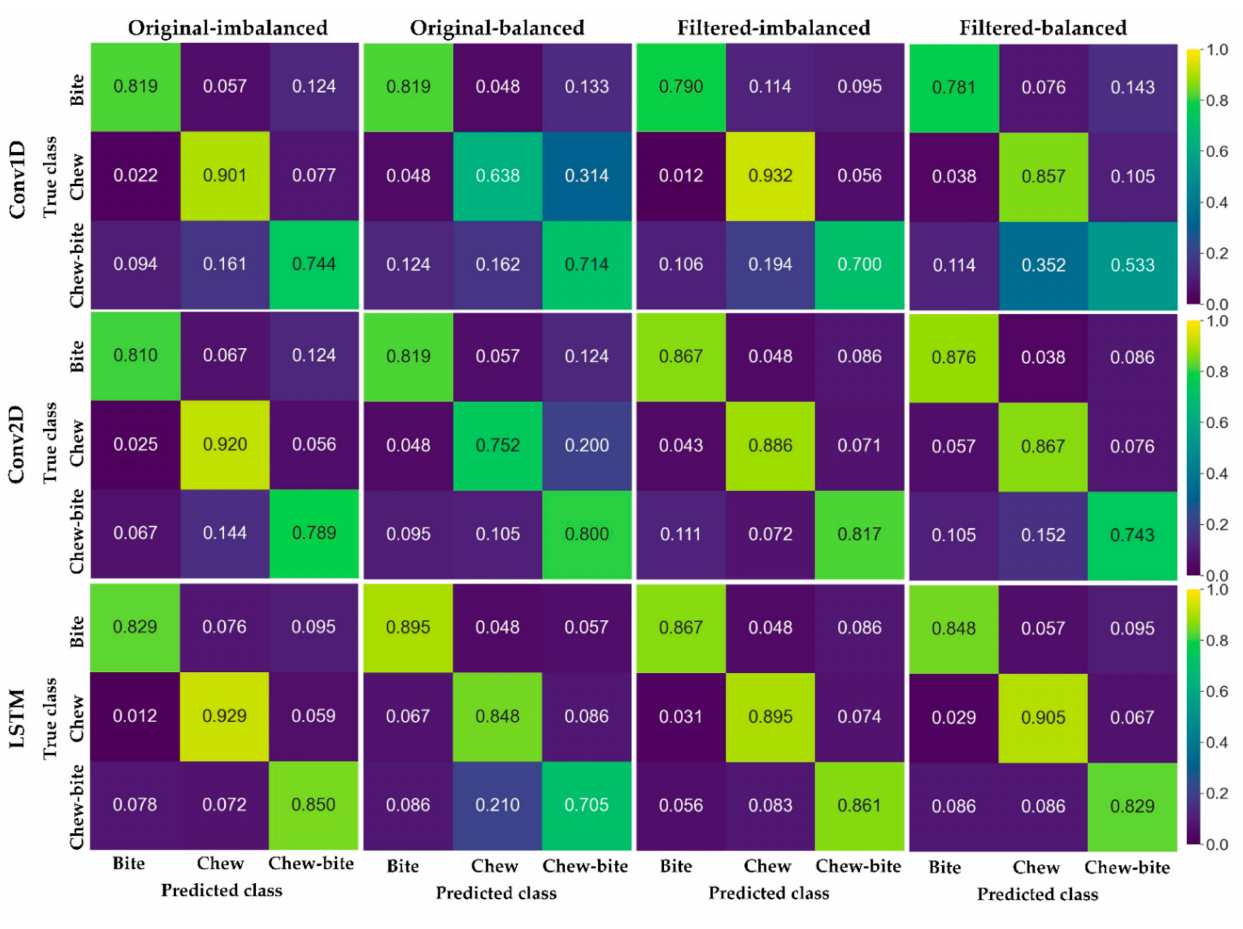
Figure 8. Confusion matrixes of the three deep learning models for classifying the ingestive behaviors in various datasets. Conv1D represents one-dimensional convolutional neural network; Conv2D represents two-dimensional convolutional neural network; and LSTM represents long short-term memory network. “Original” indicates the original dataset without any filtering; “Filtered” indicates the dataset was filtered with the bandstop filter to remove background beeping sounds; “imbalanced” indicates the dataset with unequal audio file sizes for the three ingestive behaviors; and “balanced” indicates the dataset with equal audio file sizes for the three ingestive